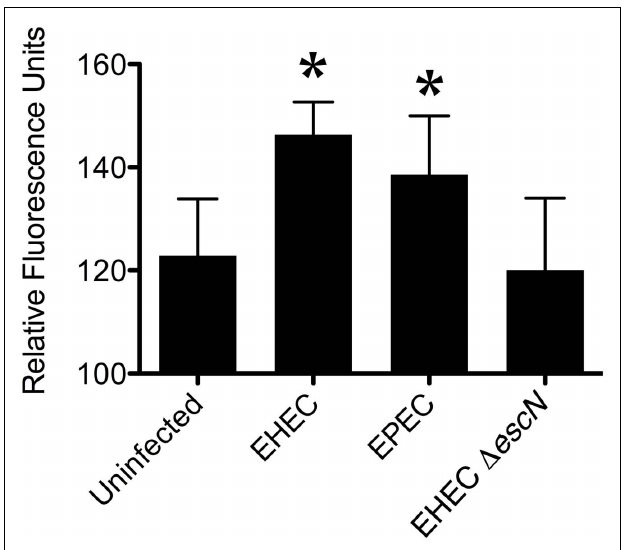
FIGURE 2 | Enterohemorrhagic Escherichia coli infection produced additional gross monolayer damage that was diminished by inhibition of calpain. Uninfected CaCo-2a CON monolayers (A) , or monolayers infected for 2h with EPEC (C) or EHEC, with (D) or without (B) a 1-h pretreatment with Calpastat (2.5 μ M) were visualized by SEM under 1000 × magnification. Scale bars are 100 μ